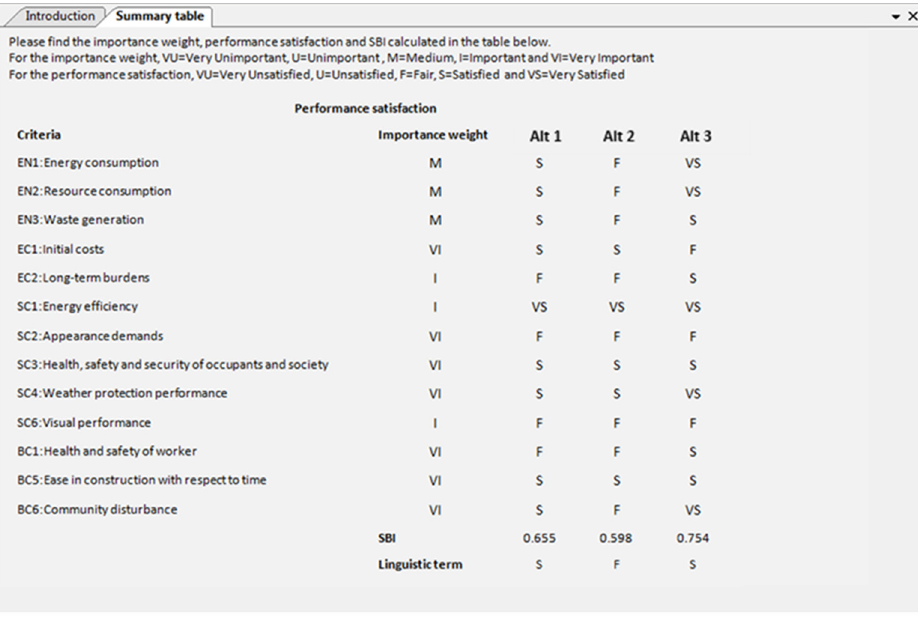
Figure 7. Summary of the design